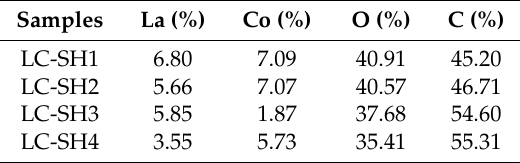
Table 4. Surface atomic concentration of the catalysts with different amounts of nitrogen.